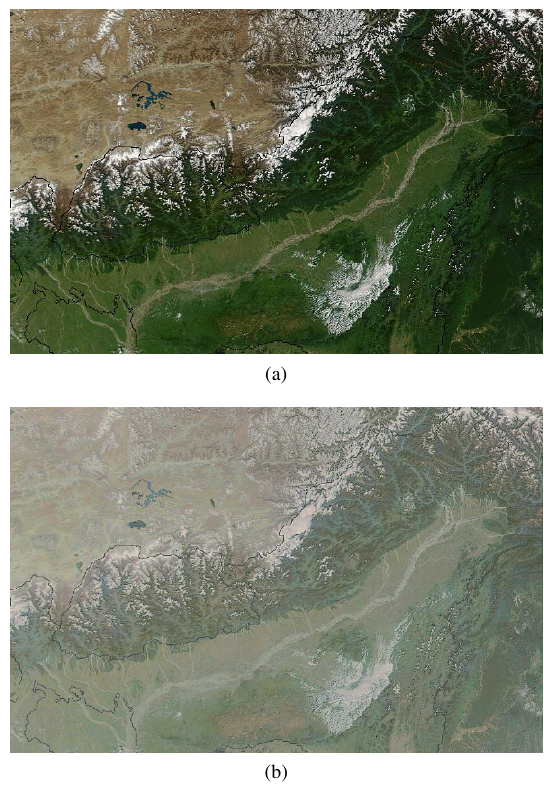
Figure 5: The MODIS imagery before and after data Gaussian-